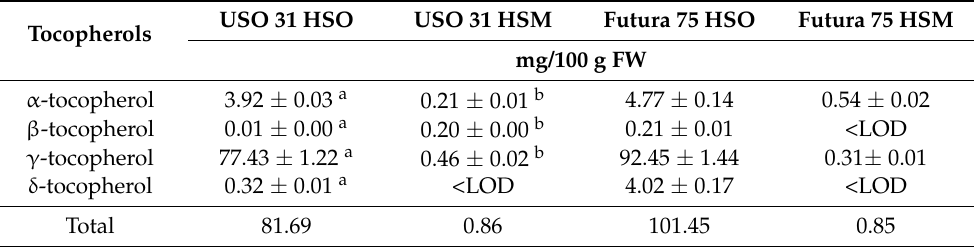
Table 4. Determination of tocopherols ( α - δ ) in USO 31 and Futura 75 hempseeds oil (HSO) and their processing byproducts (hempseed meal,